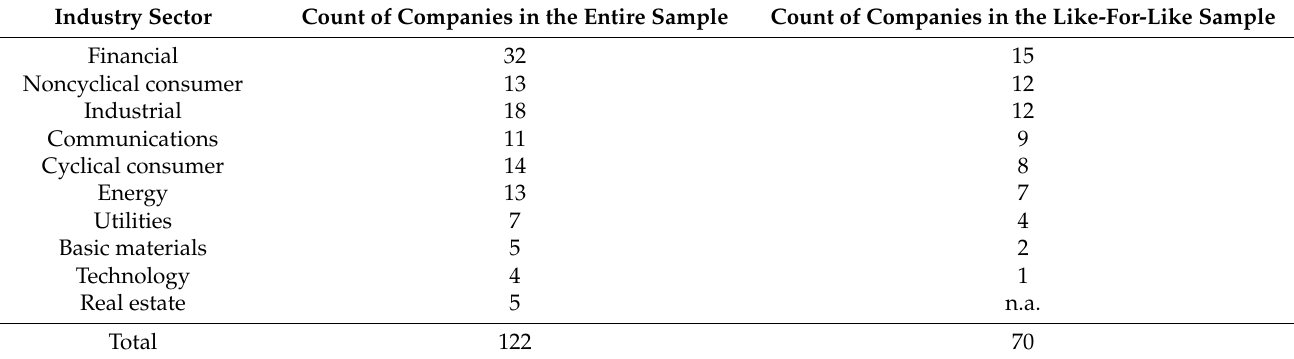
Table 1. Industry overview of the sample for mission statement analysis—created by authors. Industry Sector Count of Companies in the Entire Sample Count of Companies in the Like-For-Like